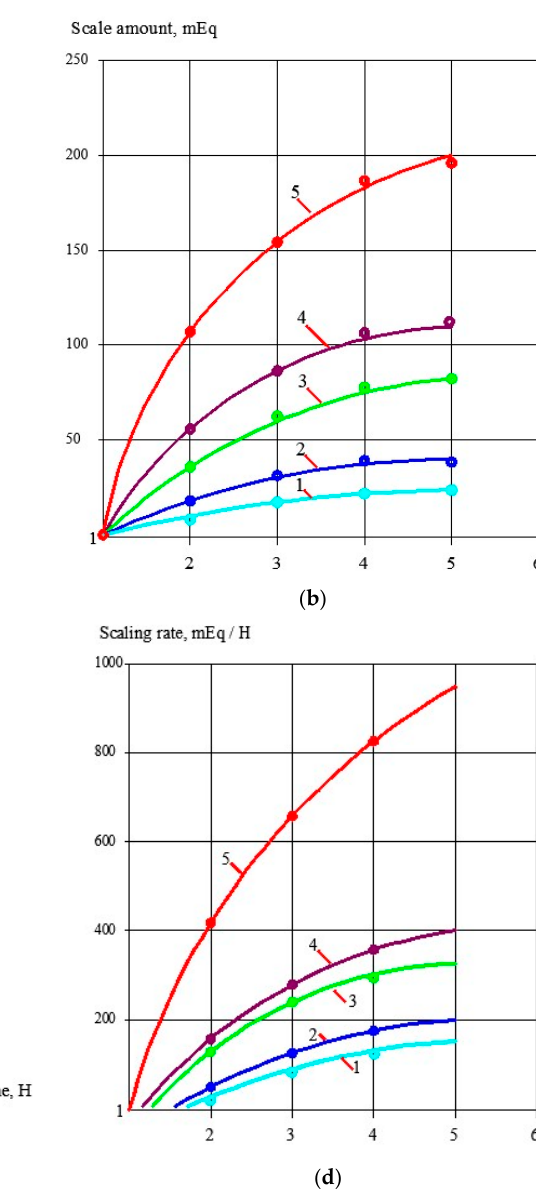
Figure 2. Evaluation of calcium carbonate scaling rates in membrane elements with reverse osmosis low pressure membranes: dependences of concentrations of calcium in concentrate volume on K values ( a ); dependencies of accumulated calcium carbonate amount on K ( b ); dependencies of calcium carbonate amount on time of experiment T ( c );dependencies of calcium carbonate scaling rates on K ( d ); 1—Aminat-K, dose 10 ppm; 2—Aminat-K, dose 5 ppm; 3—Jurby-Soft, dose 10 ppm; 4—Jurby-Soft, dose 5 ppm; 5—without antiscalant.